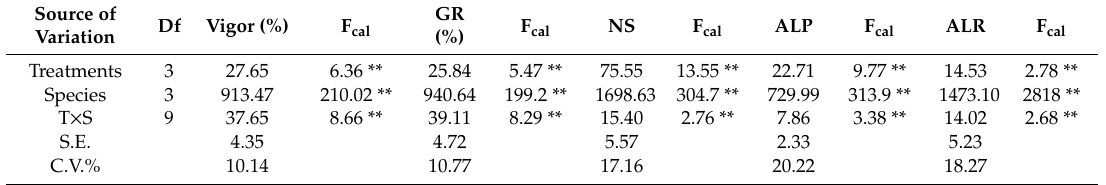
Table 4. ANOVA of standard germination test in four plant species under UV-C radiation.